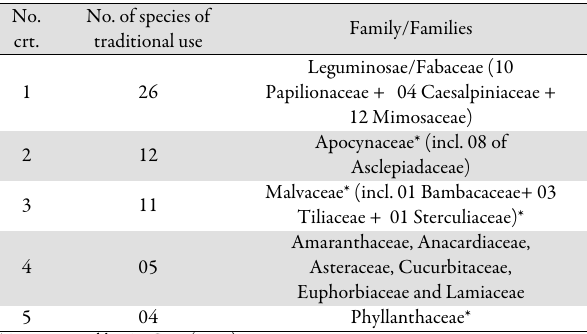
Fig. 2. Plant-use pattern in regard to growth forms